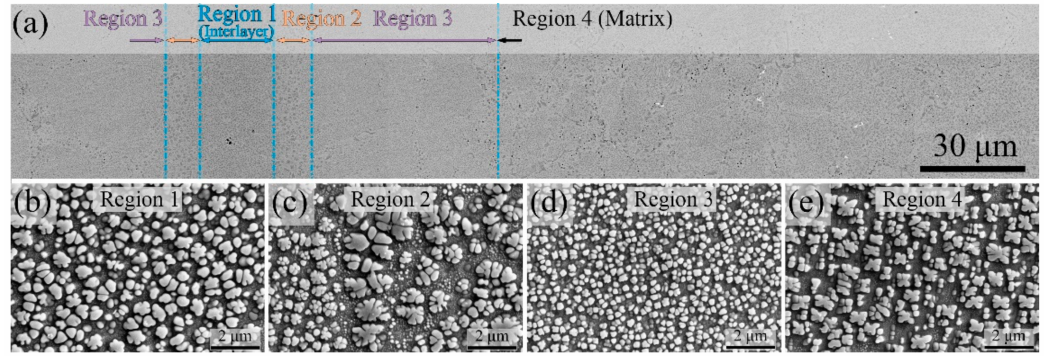
Figure 3. ( a ) Backscattered electron (BSE) images of FGH96 SSDB joint from the bonding region to the matrix region, and the γ (cid:48) morphology in different regions of ( a ): ( b ) region 1, ( c ) region 2, ( d ) region 3, and ( e ) region